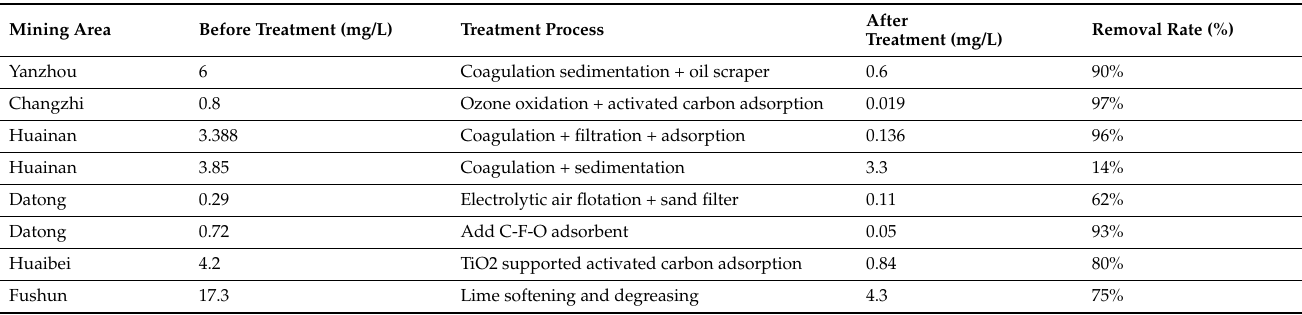
Table 3. Trace oil pollutants in mine